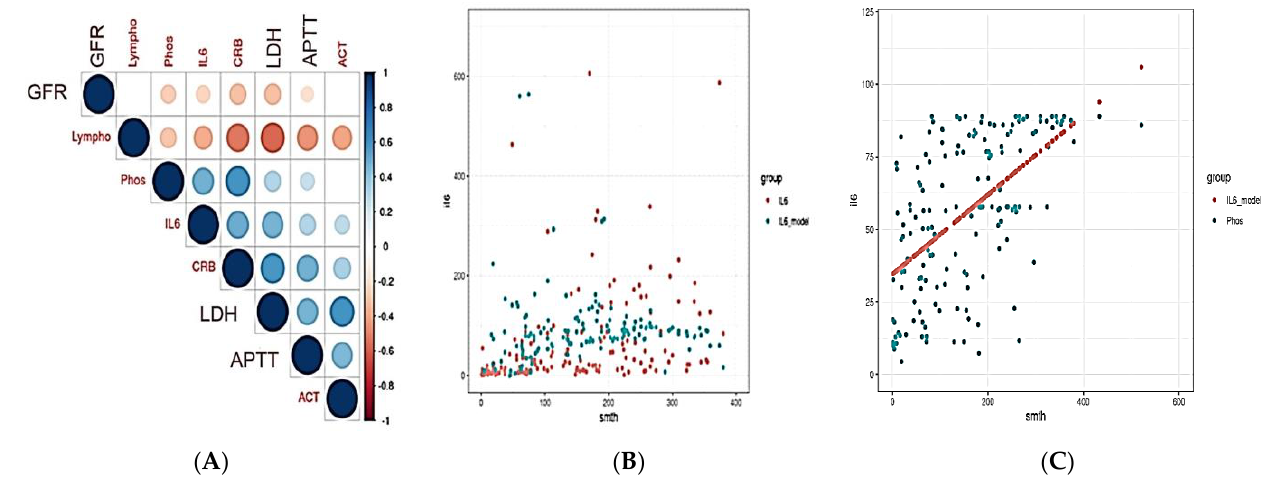
Figure 3. Correlation coefficients of the biochemical analytes in patients with COVID-19 ( A ) and multiple regression model for IL-6 ( B ) and PLA2 ( C ) levels.